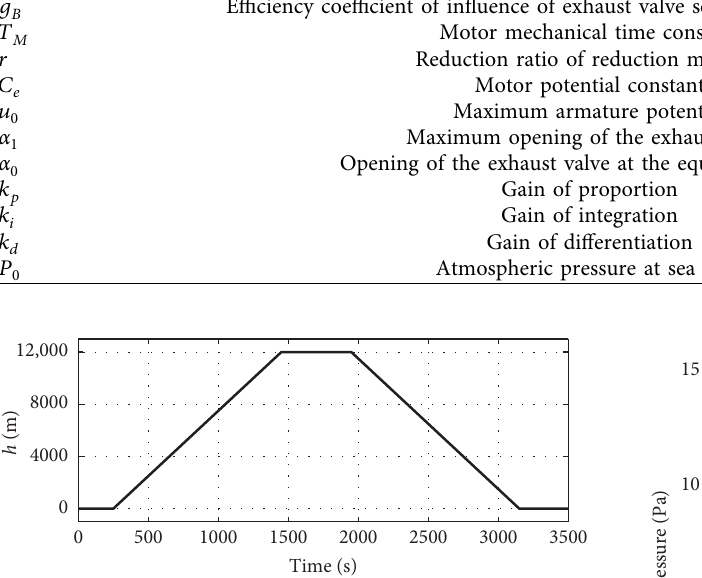
Figure 4: Relationship between flight height and time.